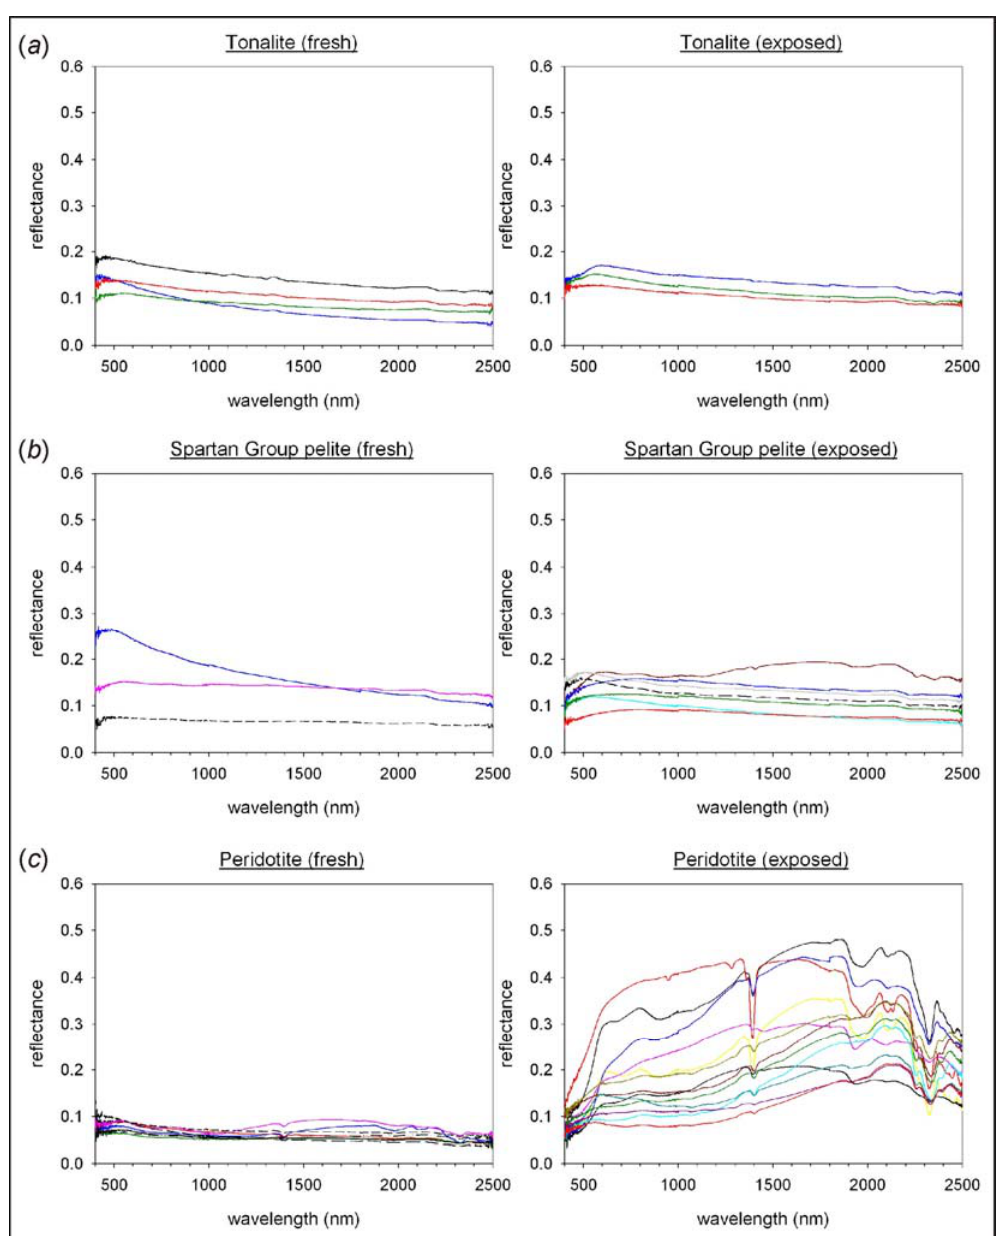
Figure 8. Reflectance spectra typical of fresh (left) and exposed (right) surfaces in the study area for ( a ) tonalite, ( b ) pelite, and ( c )